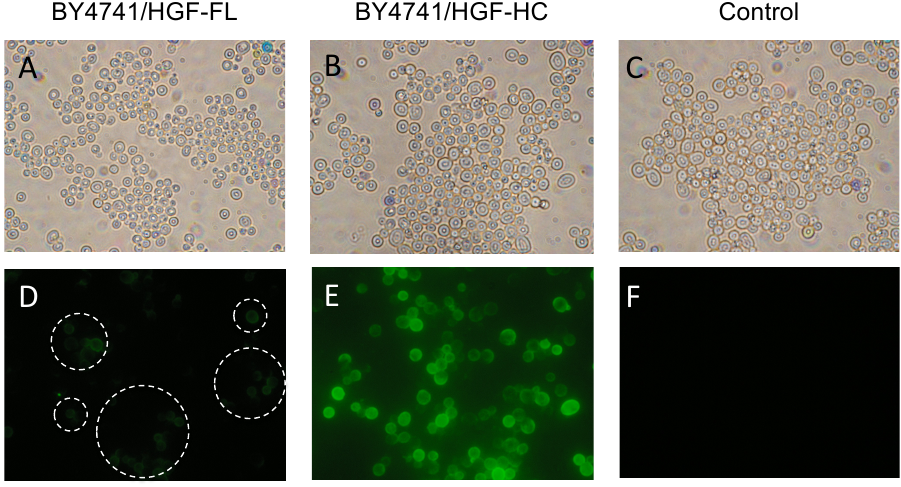
Figure 2. Immunofluorescence microscopic observation of HGF on Saccharomyces cerevisiae . ( A – C ) Light field micrograph. ( D – F ) Fluorescence micrograph. ( A , D ) BY4741/HGF-FL; ( B , E ), BY4741/HGF-HC; ( C , F ), BY4741/pULD1 (control). Dashed circles in ( D ) indicate areas with fluores- Fig. 2. Shibasaki et al. cent cells. HGF, hepatocyte growth factor. Scale bar = 5 µ